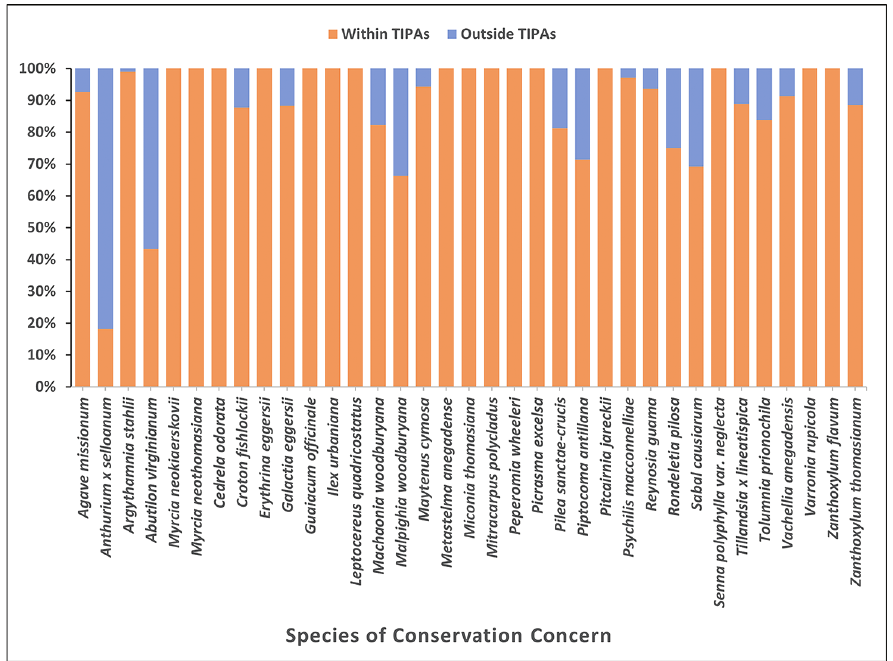
Figure 3. Representativeness of the Species of Conservation Concern within the BVI TIPAs network. Data show percentage of the records for each species that occur within or outside the TIPAs